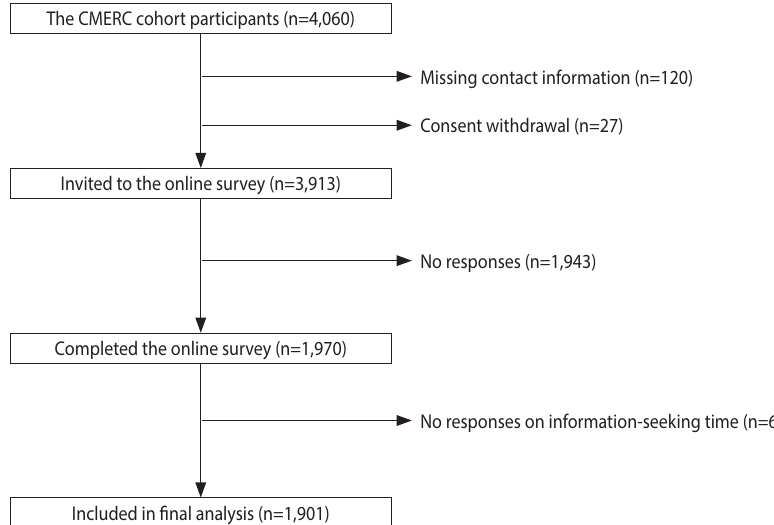
Figure 2. Flow chart of participant enrollment and study design from Cardiovascular and Metabolic Disease Etiology Research Center (CMERC)